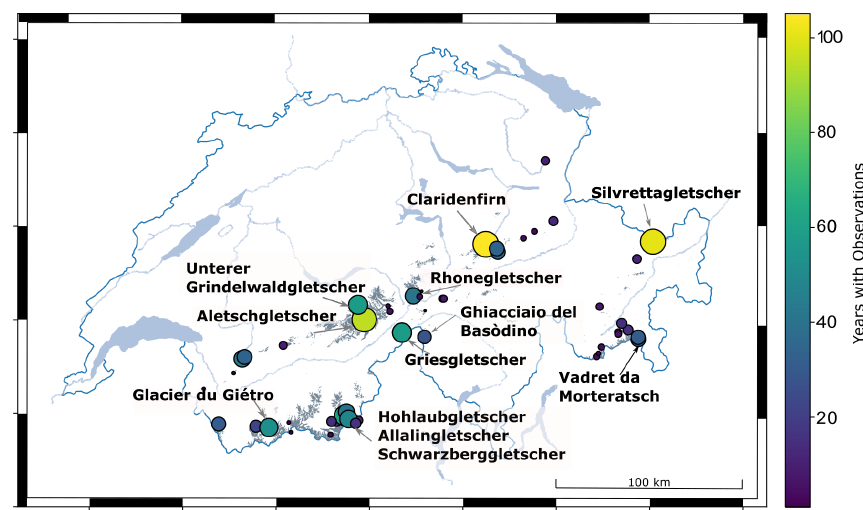
Figure 1. Location of Swiss glaciers with point mass balance measurements. The size and colour of each dot indicates the number of years with measurements. Glaciers with long time series are labelled.